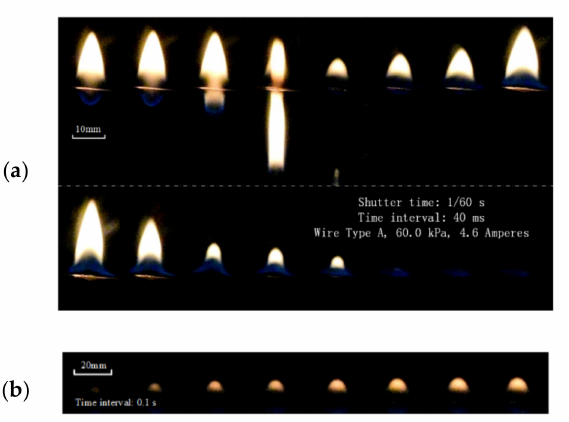
Figure 6. Flame disappearance in a short period of time caused by dripping at 60.0 kPa: ( a ) the bright flame flickers and disappears after a drop and ( b ) the flame shows